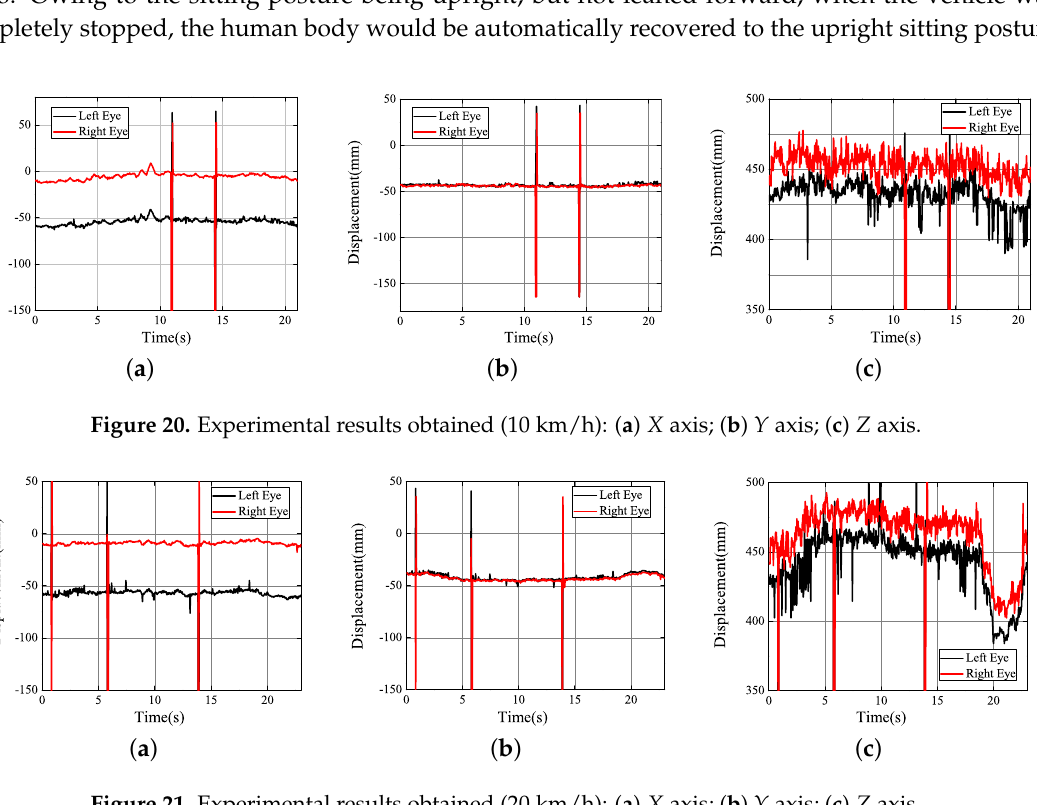
Figure 21. Experimental results obtained (20 km/h): ( a ) X axis; ( b ) Y axis; ( c ) Z